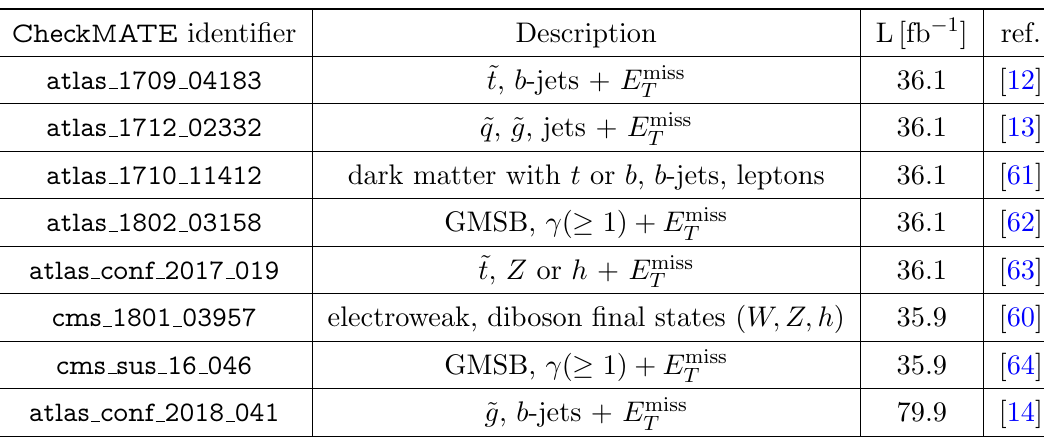
Table 1 . The analyses used in this